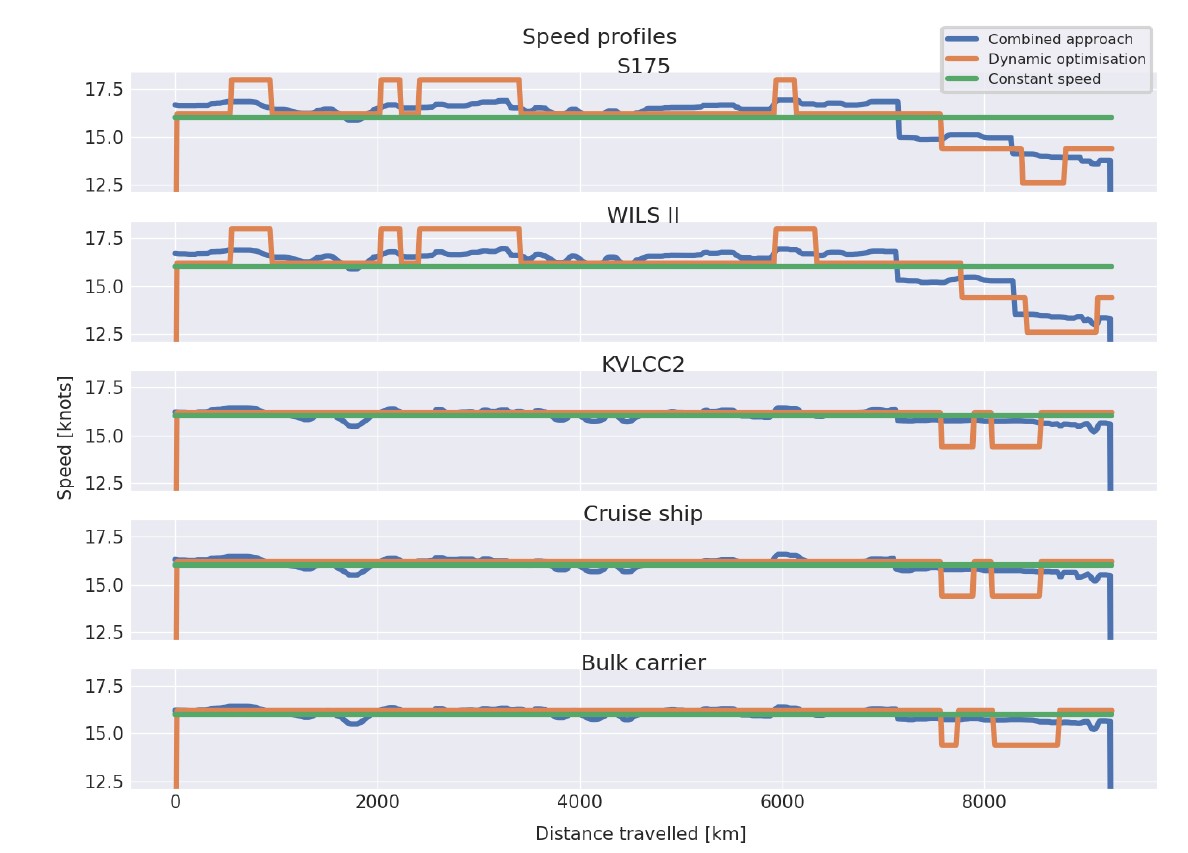
Figure 8. Speed profile comparison between the proposed combined method, dynamic optimisation and fixed speed for all